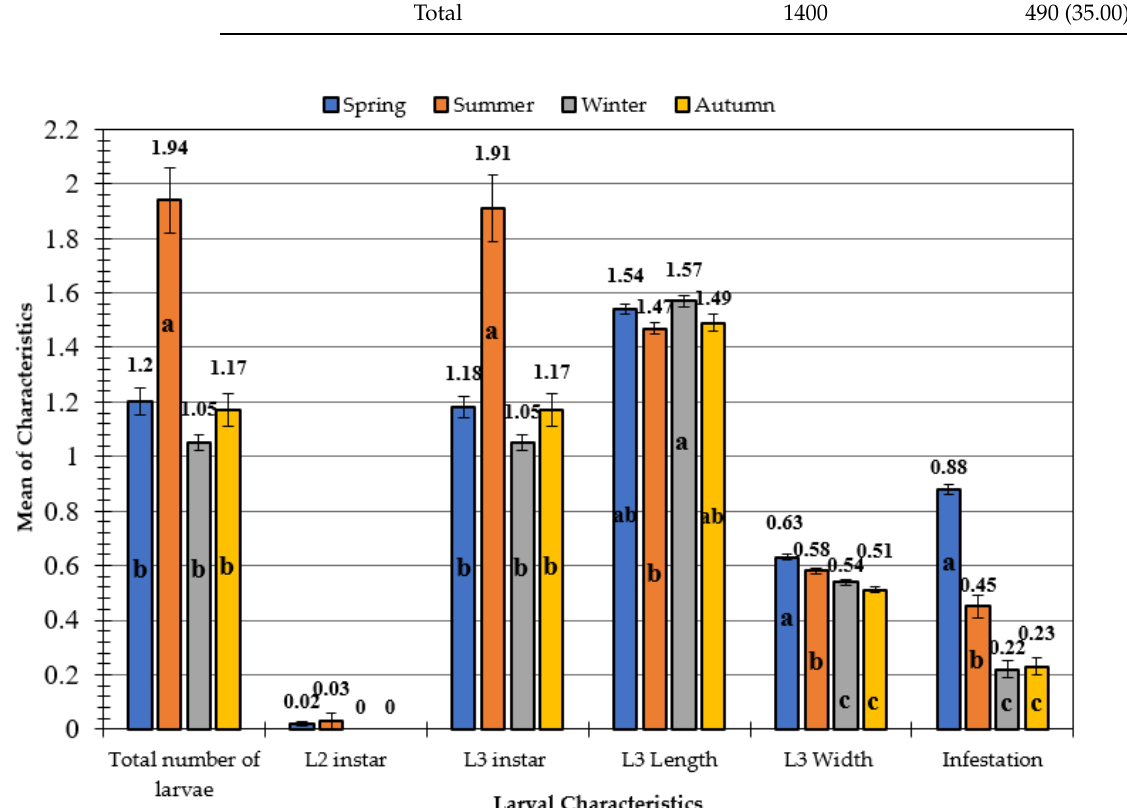
Figure 1. Effect of season on larval characteristics in infested goats. Mean values with different letters (a, b, c) are significantly different at p ≤ 0.05 between seasons.